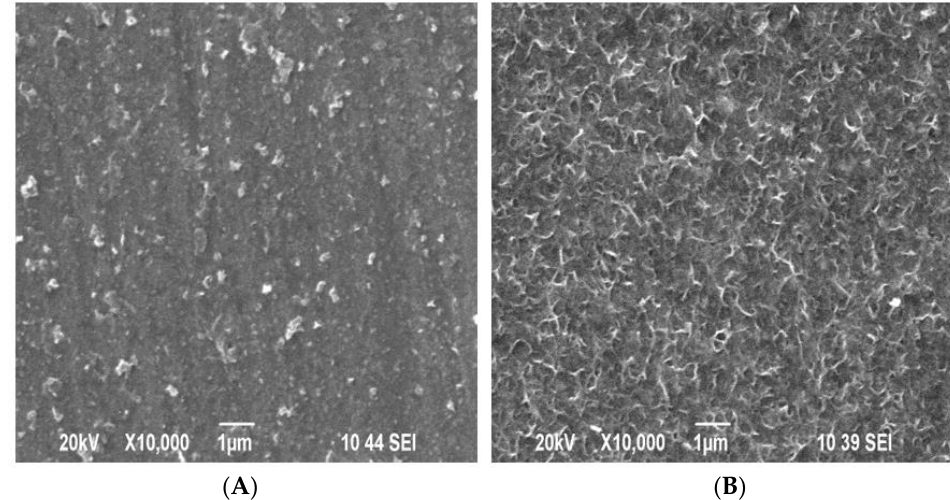
Figure 1. SEM micrographs of hybrid ZnO-containing coatings: ( A ) ZnO nanoparticles before electrodeposition of ordinary zinc; ( B ) final coating after zinc electrodeposition.